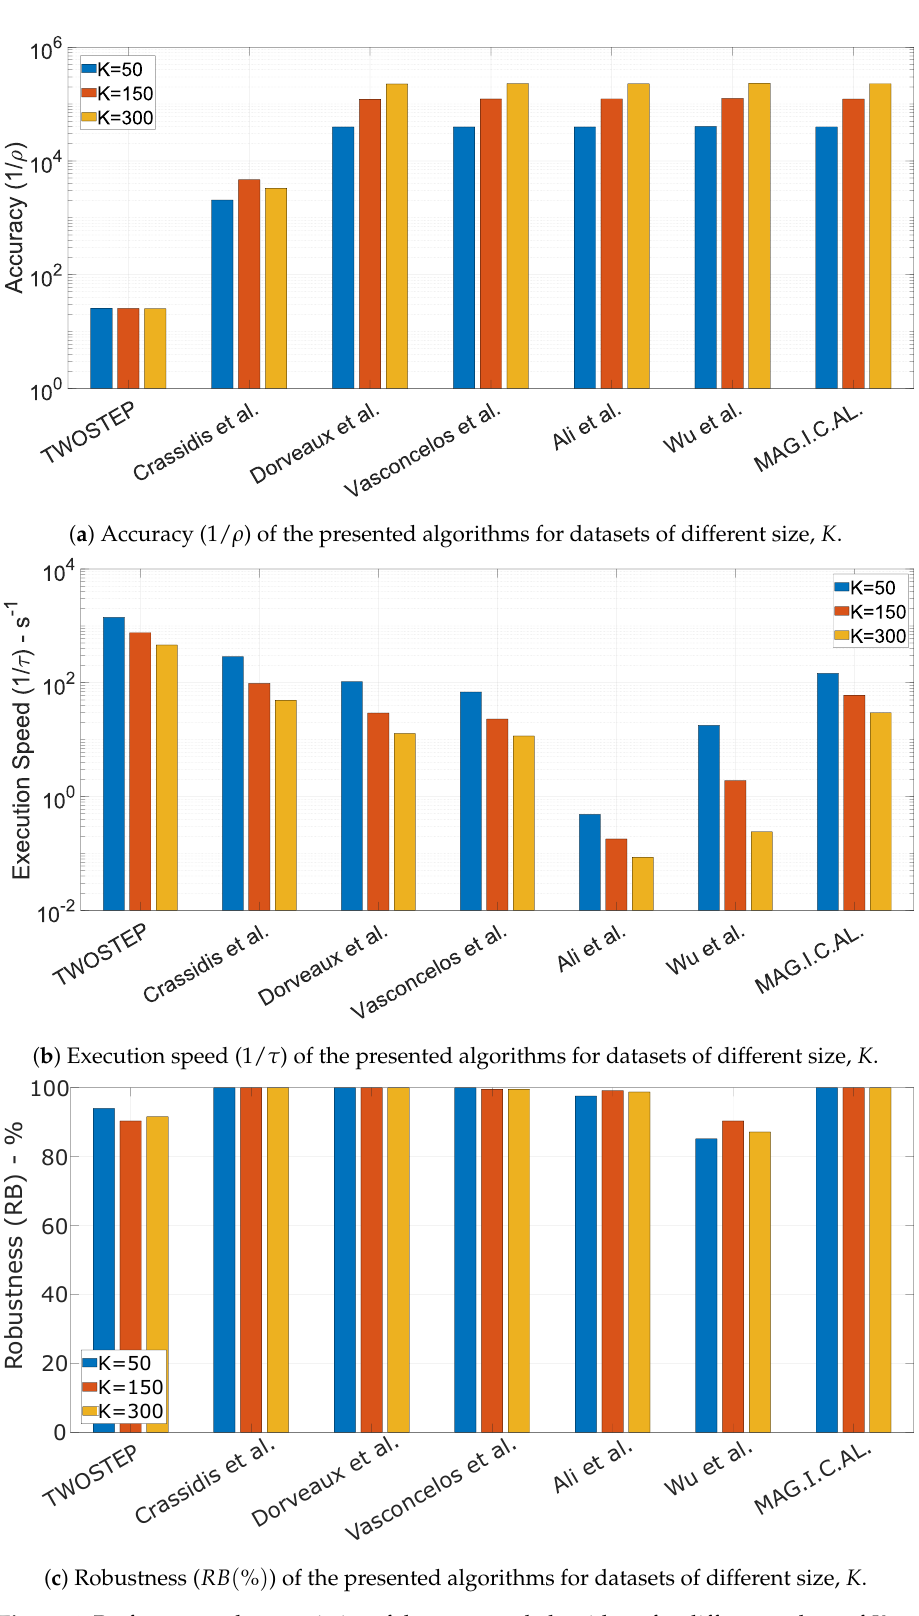
Figure 4. Performance characteristics of the presented algorithms for different values of K